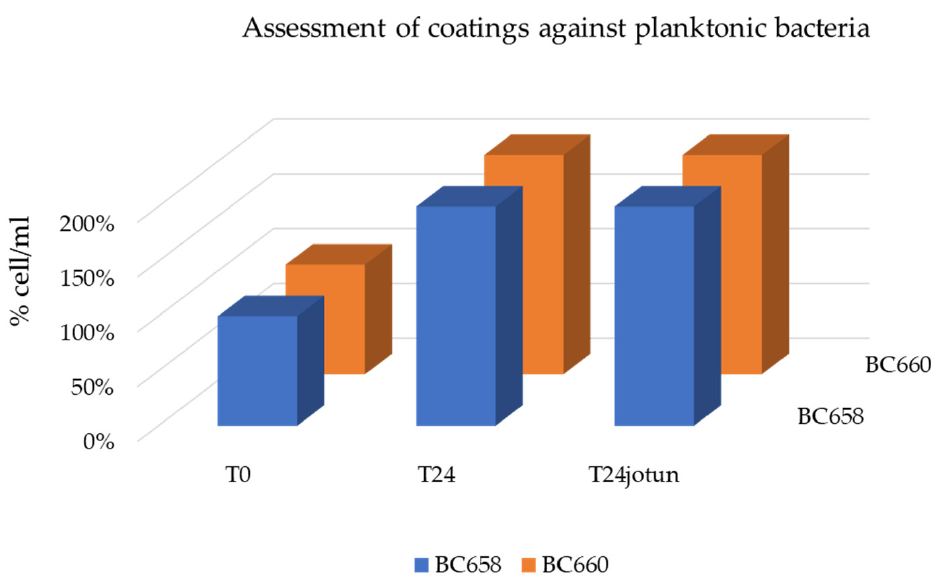
Figure 13. Planktonic bacterial growth after 24 h of incubation in presence of treated glass slides. No toxicity effects due to the release of the coatings in the aquatic environments was observed after 24 h of incubation in continuous agitation at 30 °C. Experiments with the commercial coating Jotun were carried separately.